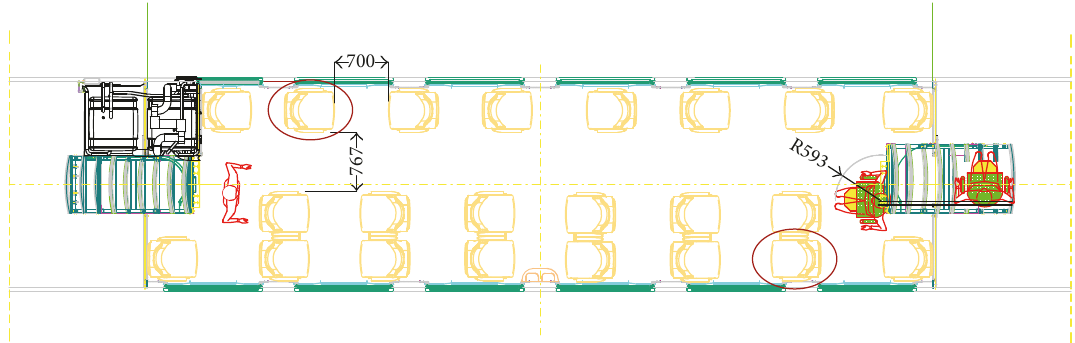
Figure 21: Position of the sensors (red circles) on the first floor.